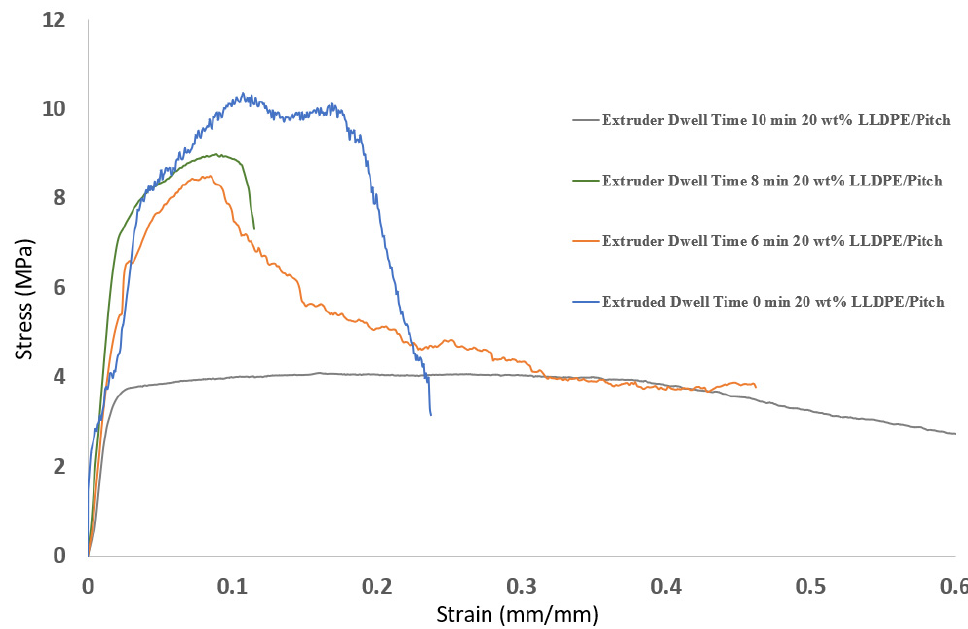
Figure 5. LLDPE/MP fibres, tensile strength of four different extrusion dwell times. Table 4. Tensile strength, tensile modulus, and strain at failure of LLDPE/MP fibres for different extrusion dwell times. (Figures in brackets represent the standard deviation).